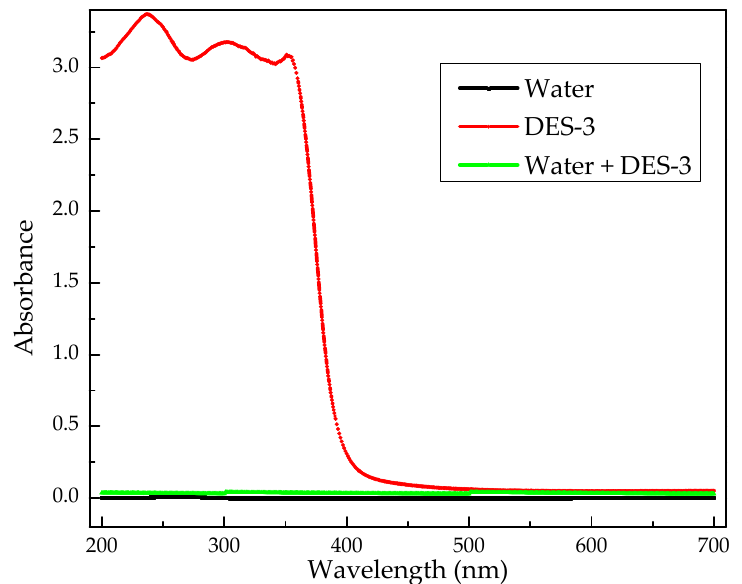
Figure 12. UV-Vis spectra for pure water (black), pure DES-3 (red) and water after mixing with DES-3 and separation (green).